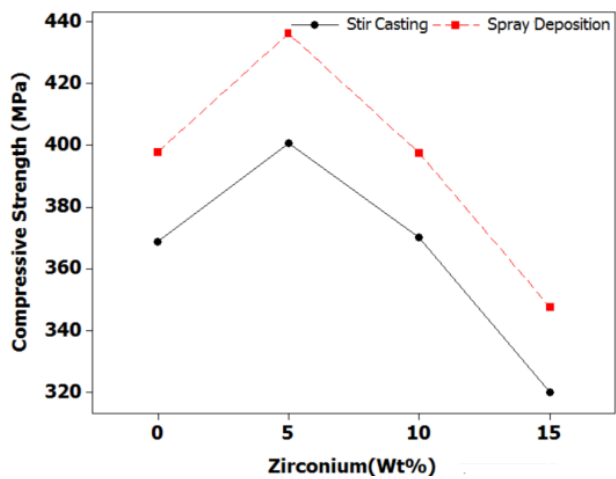
Figure 15. Compressive strength interaction plot.